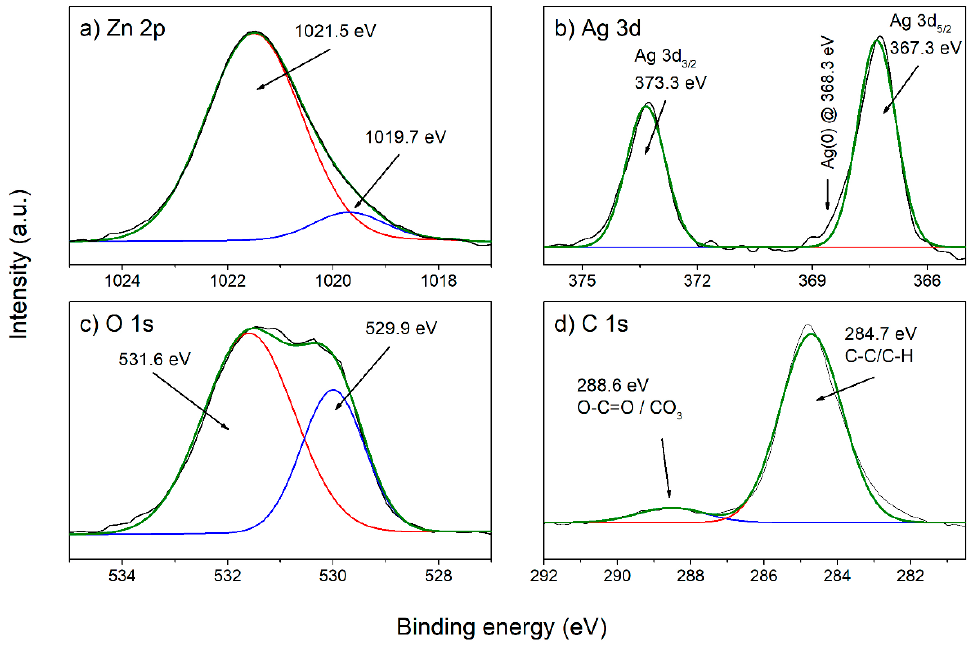
Figure 7. High-resolution spectra of Ag-doped ZnO NP (3000p used for Ag deposition in PLD) with fit spectra for ( a ) Zn 2p 3/2 , ( b ) Ag 3d, ( c ) O 1s and ( d ) C 1s . XPS spectral data are used for the atomic ratio calculation for each element present in the XPS spectrum (Zn, O, Ag, and C). From atomic ratios, after subtraction of impuri- ties, the Ag weight ratio in ZnO NP can be calculated, but such calculated value pertains only to the depth range 3 – 5 nm monitored by XPS. In Figure 8, the Ag weight ratio (cal- culated using XPS data), which is dependent on the number of pulses used for Ag depo- sition in PLD, is shown. It can be observed that the Ag silver ratio grows while the PLD number of pulses increases, up to a maximal value of 4.5 wt.% at 3000 pulses.